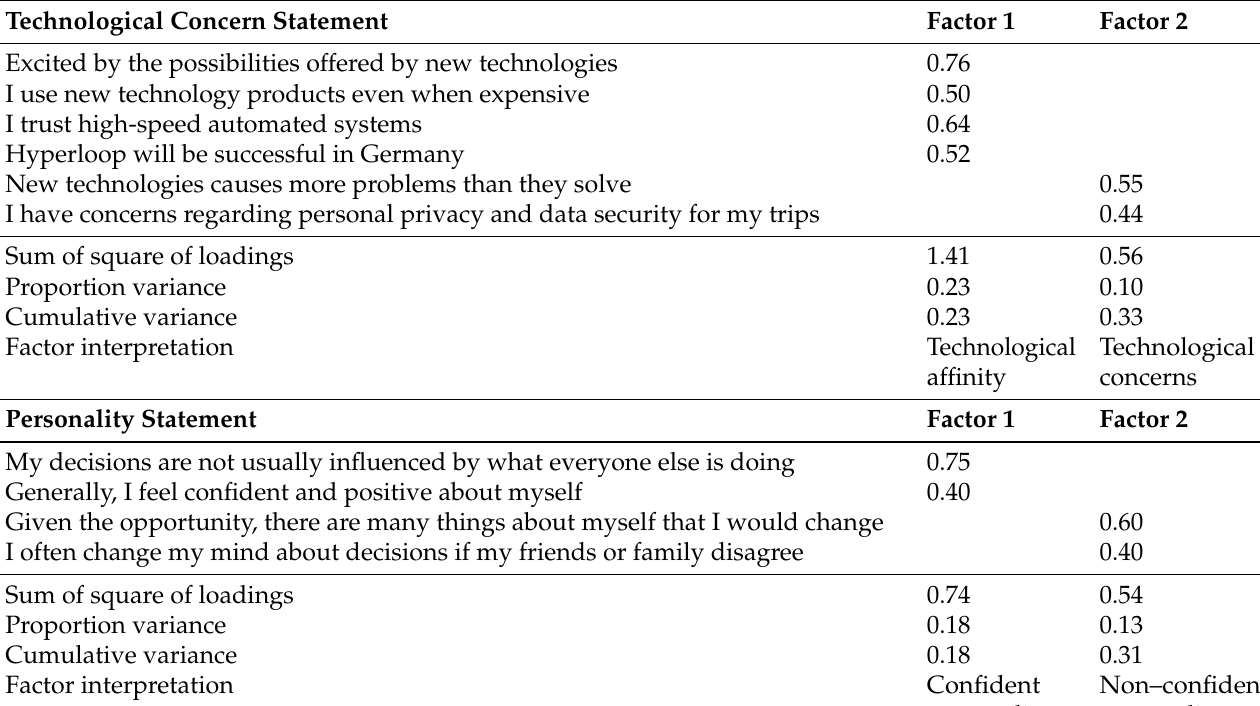
Table 4. EFA results for technology and personality-related